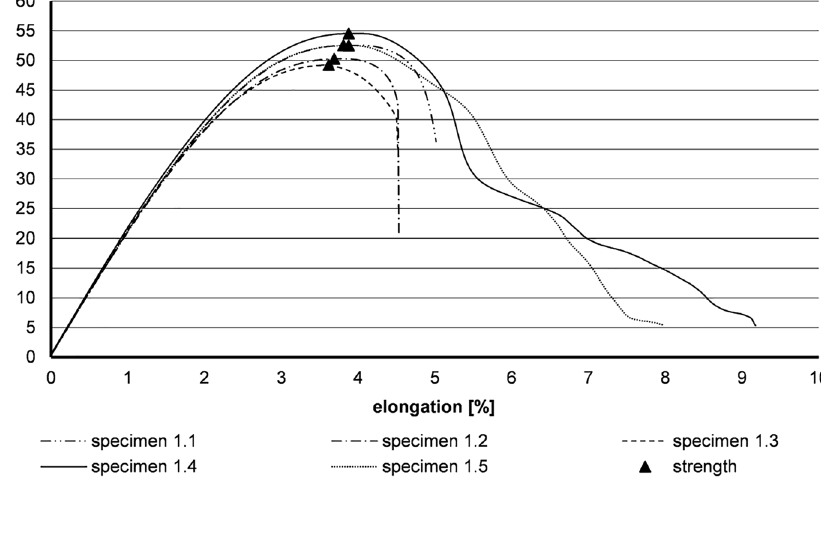
Fig. 10 Overview of maximum tensile strength for the differ- ent filament